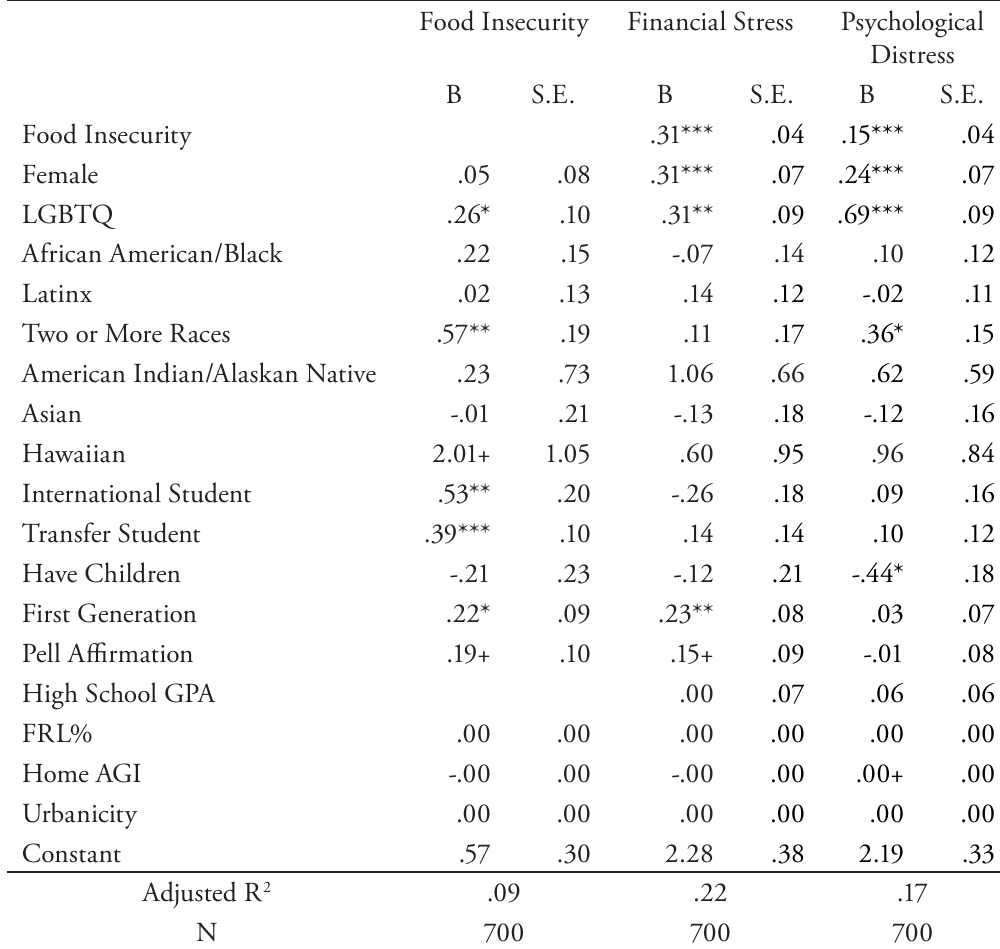
Table 3: Linear Regressions Predicting Food Insecurity, Financial Stress, and Psychological